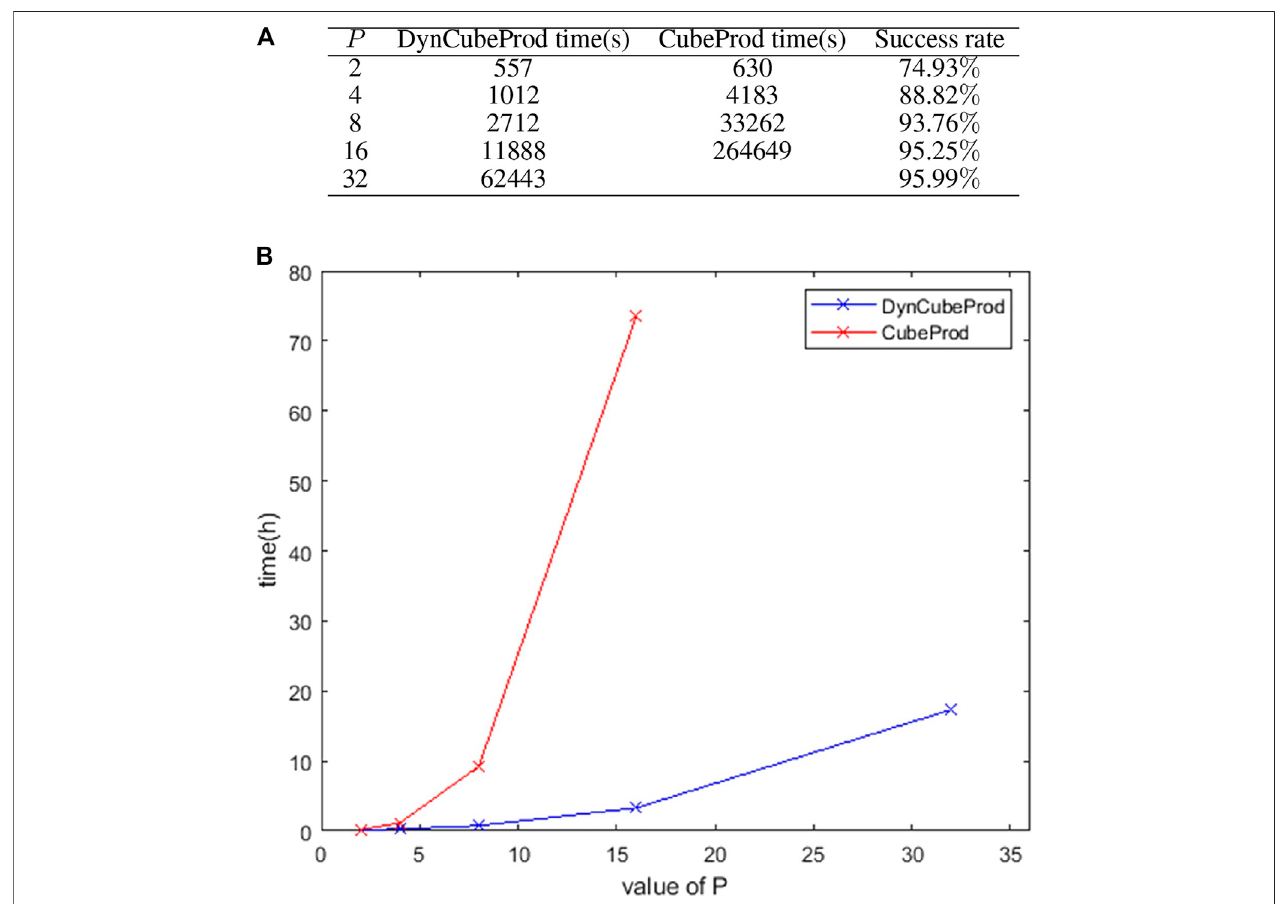
FIGURE3|(A) ComputationtimeandsuccessratiowhenDynCubeProdandCubeProdwereappliedtoiJO1366underaerobicconditionsfordifferentvaluesof P . (B) Visual comparison of the computation time of DynCubeProd and CubeProd of